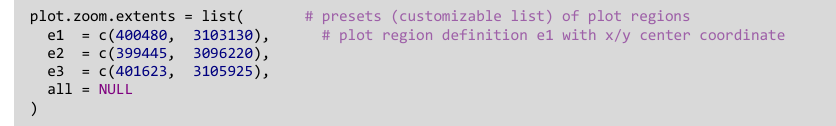
Codebox 5. Definition of predefined plot extents that allow for the quick plotting of frequently used map regions. The names, here “e1”, example CM.plotPlanView(cmgo.obj, extent =